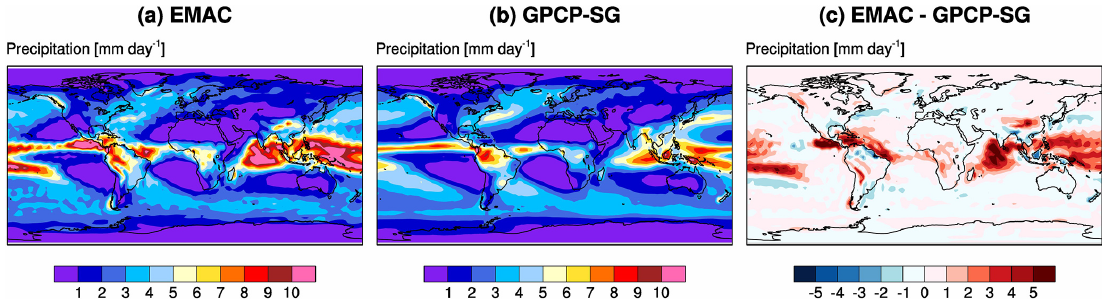
Figure 7. Similar to Fig. 2 but for